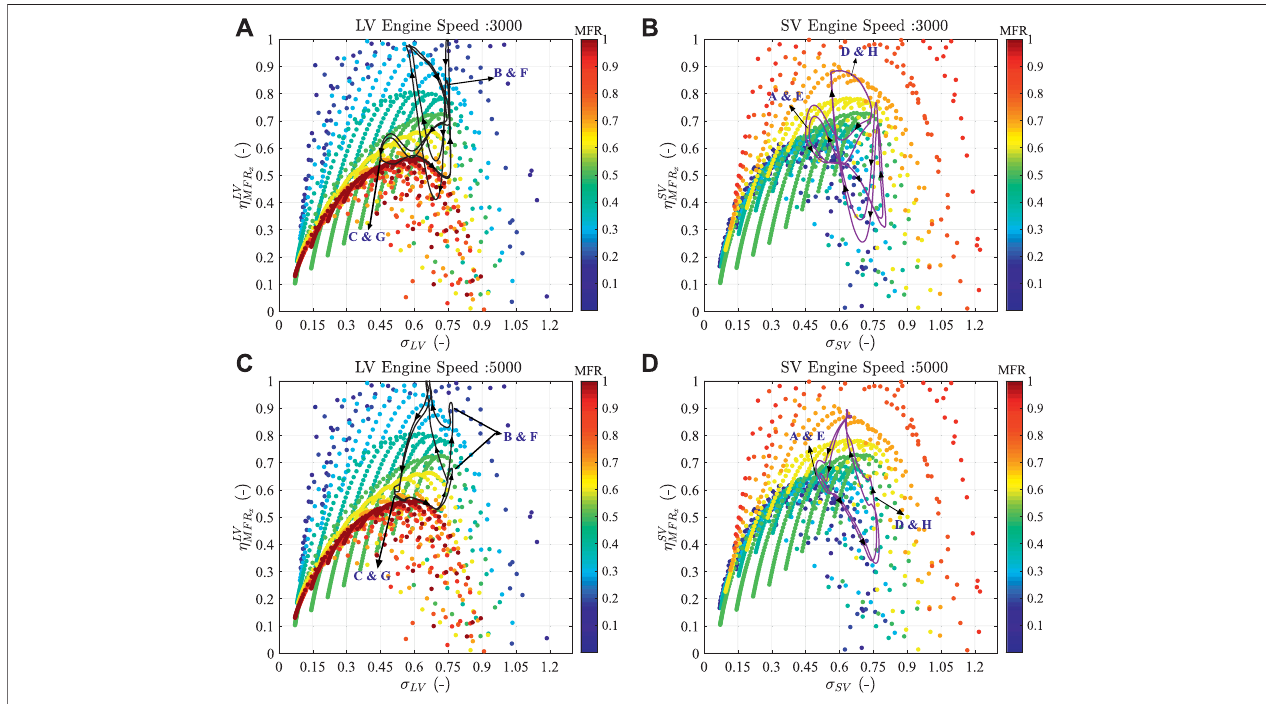
FIGURE 18 | Comparison of steady (contours) and unsteady state parameters of total to static turbine ef fi ciency (apparent ef fi ciencies) with blade speed ratio acrosseach turbinebranch. (A) and (B) Show theinstantaneousapparentef fi ciencyvaluesin longand short volute branchesforan engine speed of3,000 rpm; (B) and (D) show the instantaneous apparent ef fi ciencies in long and short volute branches for an engine speed of 5,000 rpm.